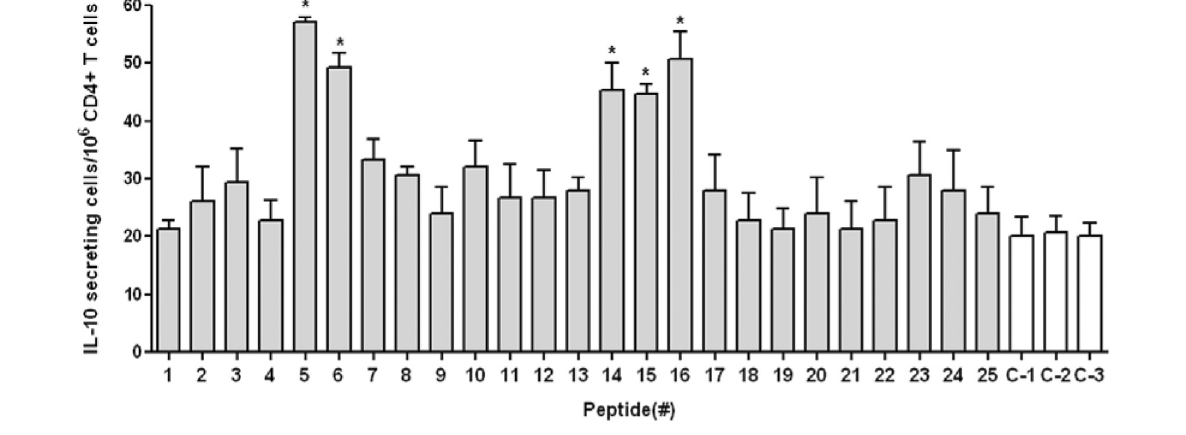
Figure 1. Screening for ergotope peptides. Twenty-five overlapping peptides and three control peptides (abbreviated C-1, C-2 and C-3), each containing 20 amino acids, were designed according to the amino acid sequence of murine CD25 (interleukin-2 receptor α chain, IL-2R α ) and CD132 (interleukin-2 receptor γ chain, IL-2R γ ). CD4 + T cells were isolated from the draining lymph nodes of TCV-treated mice at d 45 and then stimulated with different peptides at a dose of 10 μ g/mL in the presence of APC for 48 h. IL-10 + cells were detected by ELISPOT assay. Triplicate wells were used. *: P < 0.05 versus controls. Data are representative of three separate experiments with similar